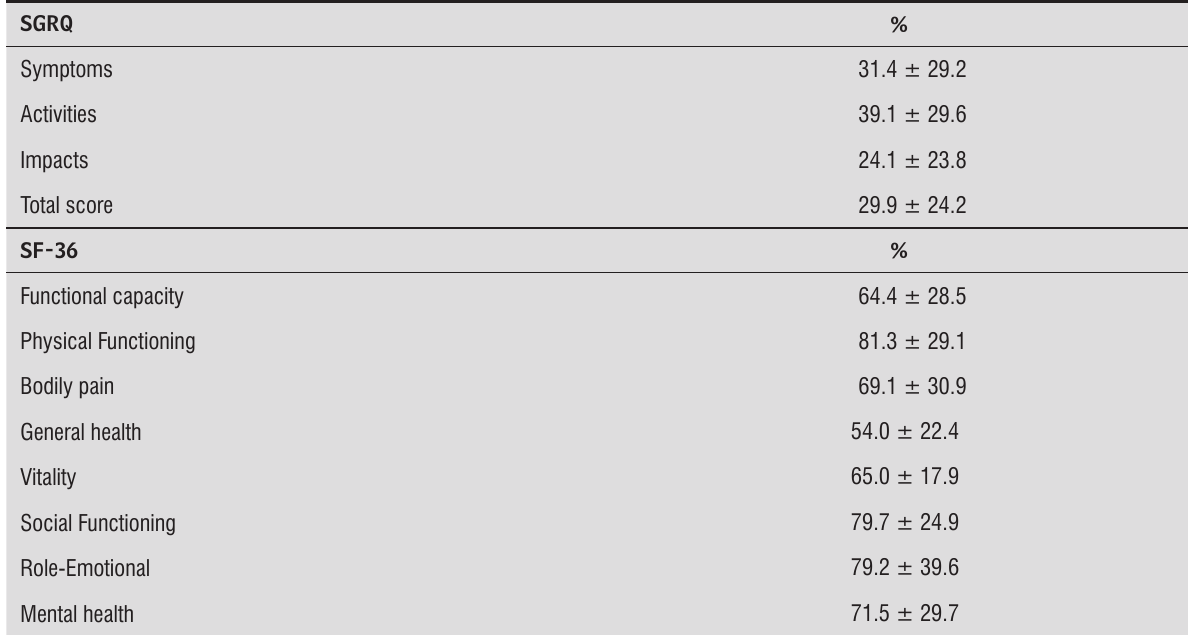
Table 3 - St George’s Respiratory Questionnaire (SGRQ) and Short Form 36 health survey questionnaire scores of the COPD group (n =